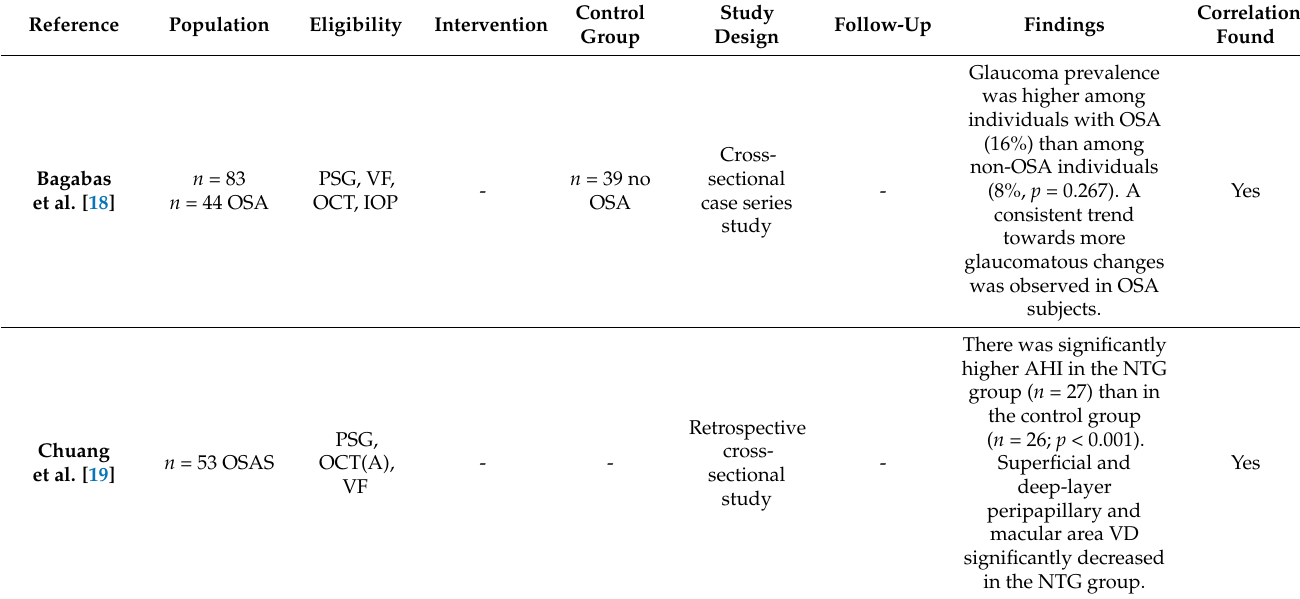
Table 1. Cross-sectional studies of the occurrence of glaucoma in sleep clinic